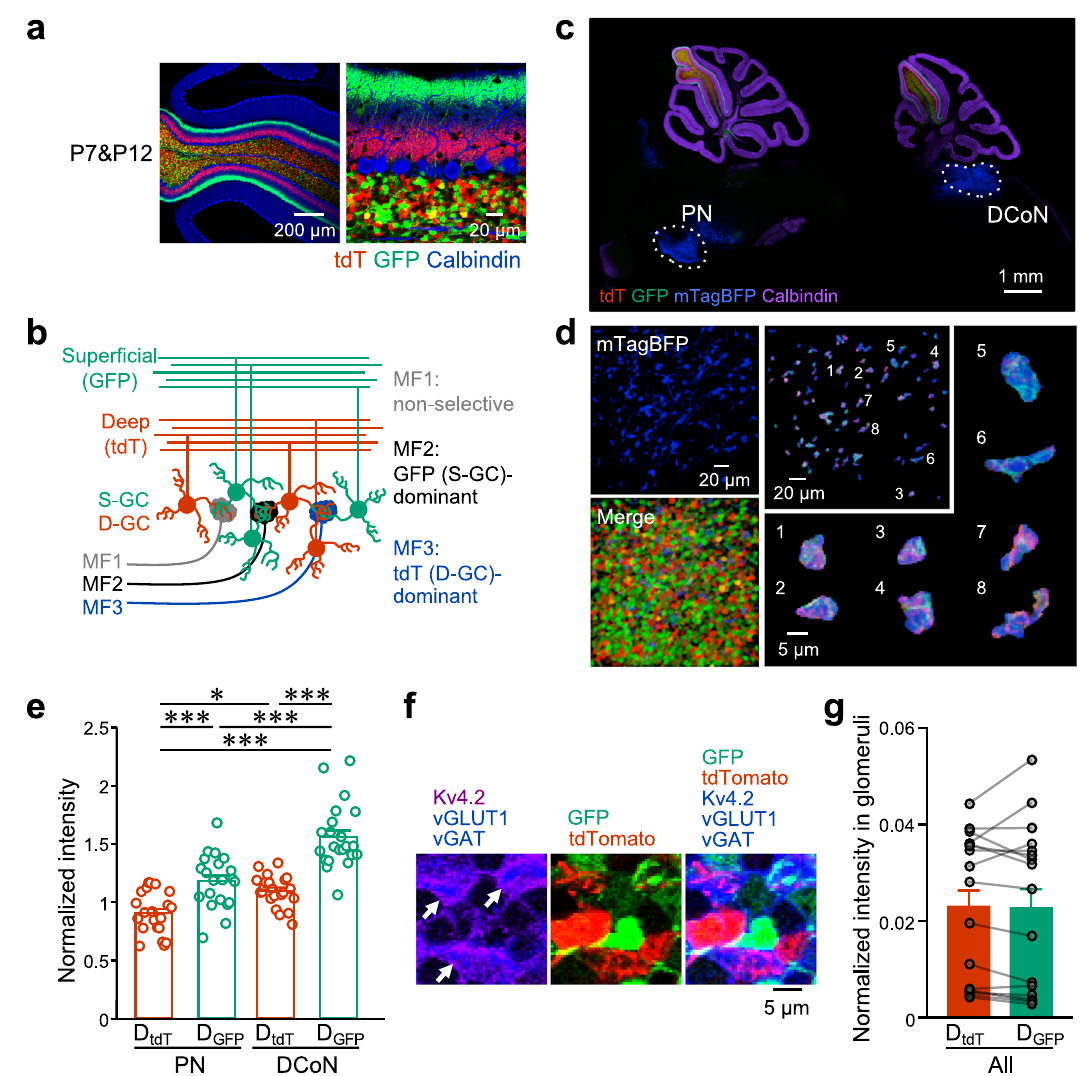
Fig. 2 Non-uniform synaptic connections with speci fi c MF terminals originating from the PN or the DCoN. a Confocal images of cerebellar slices expressing tdT (red) in D-GCs and GFP (green) in S-GCs by injection of AAV-GABR α 6-tdT at P7 and AAV-GABR α 6-GFP at P12. Slices were stained (blue) with a calbindin antibody. b A schematic drawing showing synaptic connections between speci fi c types of MFs and D-GCs or S-GCs. In the drawing, the MF2 dominantly connects with S-GCs and its terminal includes more GFP than tdT, whereas the MF3 dominantly connects with D-GCs and its terminal includes more tdT than GFP. c Confocal images of sagittal slices including whole cerebellum together with PN or DCoN. Slices were stained with a calbindin antibody (purple). Two groups of GCs are labeled with tdT (red) and GFP (green) by double injection at P7&P12, and MFs originating from PN (left) or DCoN (right) are labeled with mTagBFP (blue). d Left, representative 3D projection images of GCL, when two groups of GCs are labeled with tdT (red) and GFP (green), and DCoN-MFs are labeled with mTagBFP (blue). Right, representative 3D images of mTagBFP (blue)-positive DCoN-MF terminals, including GFP (green)-positive and tdT (red)-positive GC dendrites. e Averages of normalized intensities of tdT (D tdT ) and GFP (D GFP ) within the individual PN- and DCoN-MF terminals labeled with mTagBFP. Data in the individual 3D images are shown with open circles. *** p = 3.8 × 10 − 4 (PN, D tdT vs PN, D GFP ), *** p = 1.2 × 10 − 9 (DCoN, D tdT vs DCoN, D GFP ), * p = 0.022 (PN, D tdT vs DCoN, D tdT ), *** p = 4.8 × 10 − 7 (PN, D GFP vs DCoN, D GFP ), *** p = 2.2 × 10 − 15 (PN, D tdT vs DCoN, D GFP ), p = 1 (PN, D GFP vs DCoN, D tdT ), one-way ANOVA followed by the Bonferroni test ( N = 7 mice, 14 mice in total, 3 – 4 images per mouse). f Confocal images showing tdT- (red) and GFP-positive GC dendrites (green) included in glomeruli, which are visualized by staining with three antibodies, Kv4.2 (purple in left panels or blue in right panels), vGLUT1 (blue), and vGAT (blue). Glomeruli are shown with arrows. g Averages of normalized intensities of tdT (D tdT ) and GFP (D GFP ), labeled by double injection at P7&P12, within non-speci fi c glomeruli visualized by triple staining with antibodies against vGLUT1, vGAT, and Kv4.2. Gray circles represent individual data points. p = 0.65, Mann – Whitney test ( N = 8 mice, 3 – 5 images per mouse). Data are presented as mean ±